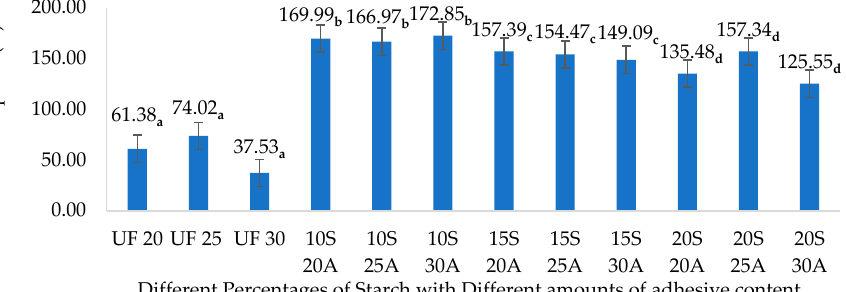
( B ) The different alphabets (a, b, c, and d) displayed beside the average values show significant differ- ences among the parameters